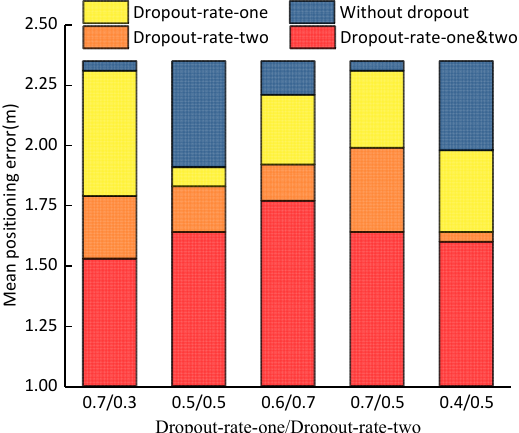
Figure 5. Effects of dropout on positioning performance. The blue part represents the absence of the dropout layer. The yellow part represents the presence of dropout rate-one only. The orange part represents the presence of dropout rate-two only. And the red part represents the presence of both dropout rate-one and dropout rate-two. There are two numbers on the horizontal axis. The former number represents the value of dropout-rate-one, and the latter number represents the value of dropout-rate-two. It can be seen from the Figure 5 that when the dropout-layer-one and dropout-layer-two ratios are 0.7 and 0.3, respectively, the mean positioning error is the smallest and is 1.53